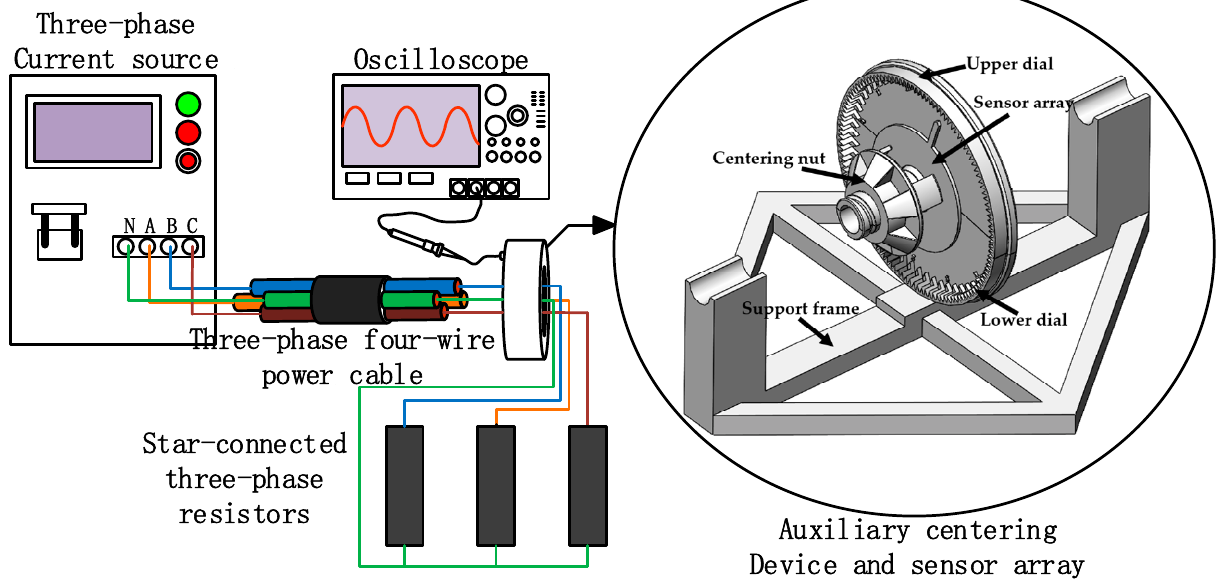
Figure 8. Schematic diagram of the magnetic field strength distribution experimental system.